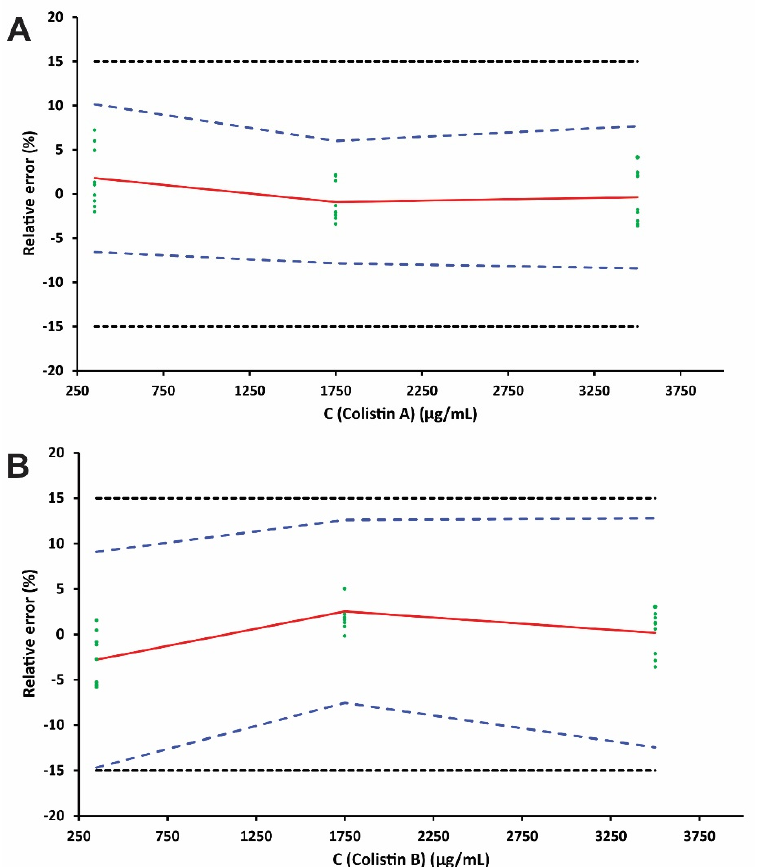
Figure 5. Accuracy profiles for the ( A ) Colistin A and ( B ) Colistin B determination in human urine samples. The red plain, blue dashed, and blank dotted lines represent the relative error (%), the accuracy profile, and the acceptance limits λ ( ± 15%), respectively.